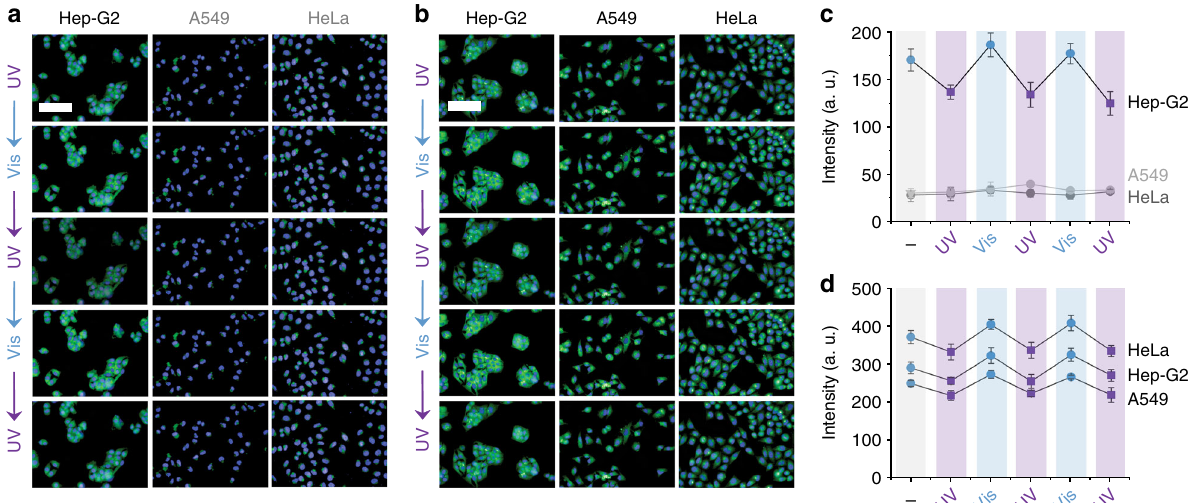
Fig. 3 Receptor-targeting intracellular photochromism of glycoprobes by UV/Vis cycling. a UV/Vis cycling of SP-Gal (20 μ M) in different cells (Hep-G2 = human hepatoma cell line; HeLa = human cervical cell line; A549 = human lung cell line). b UV/Vis cycling of SP-PEG (20 μ M) in different cells. c , Fluorescence quanti fi cation of UV/Vis cycling of SP-Gal in different cells. d Fluorescence quanti fi cation of UV/Vis cycling of SP-PEG in different cells. For fl uorescence imaging, the excitation wavelength was 360 – 400 nm and 440 nm and emission channel 410 – 480 nm and 450 – 550 nm for Hoechst and SP- Gal/SP-PEG, respectively (scale bar: 100 μ m, which is applicable to all images; The error bar represents s.d. ( n =